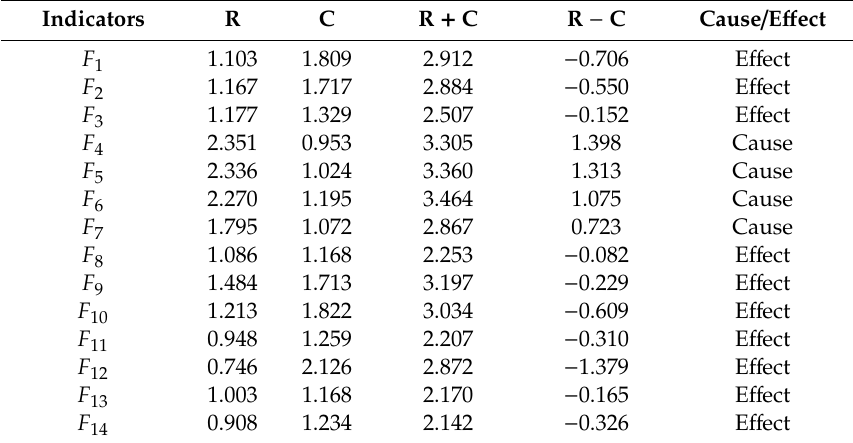
Table 7. Sum of influences given and received for each indicator.